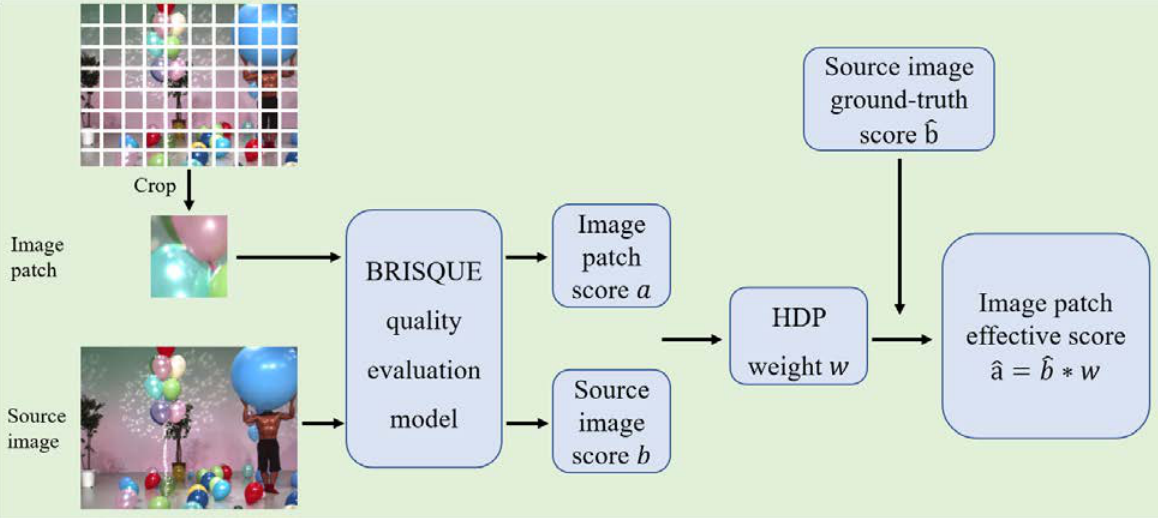
Figure 4. Heterogeneous distortion perception module.